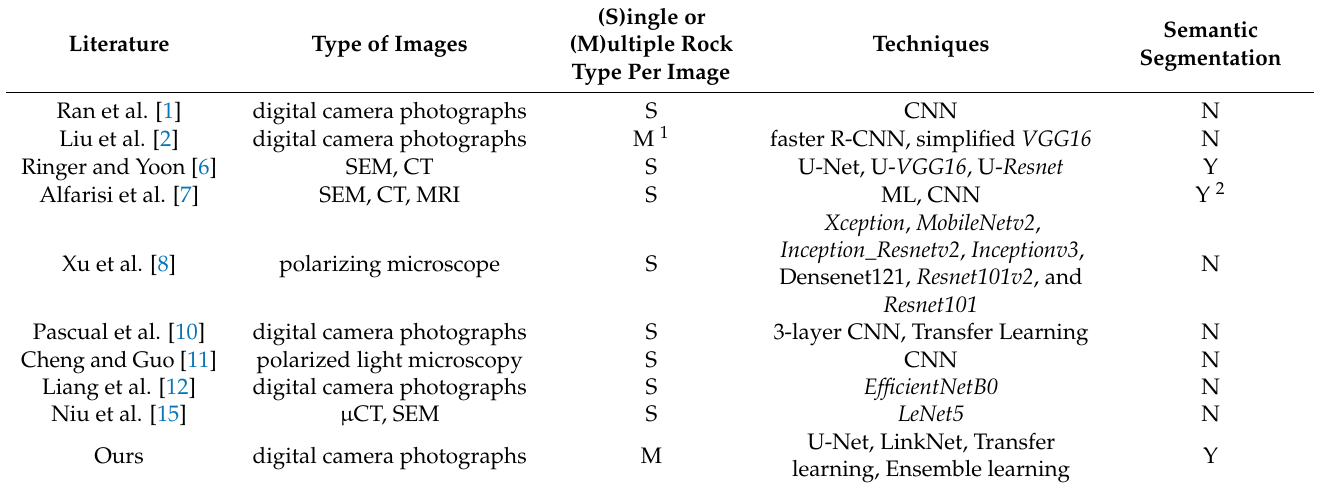
Table 1. Different types of deep learning rock type classification problems and